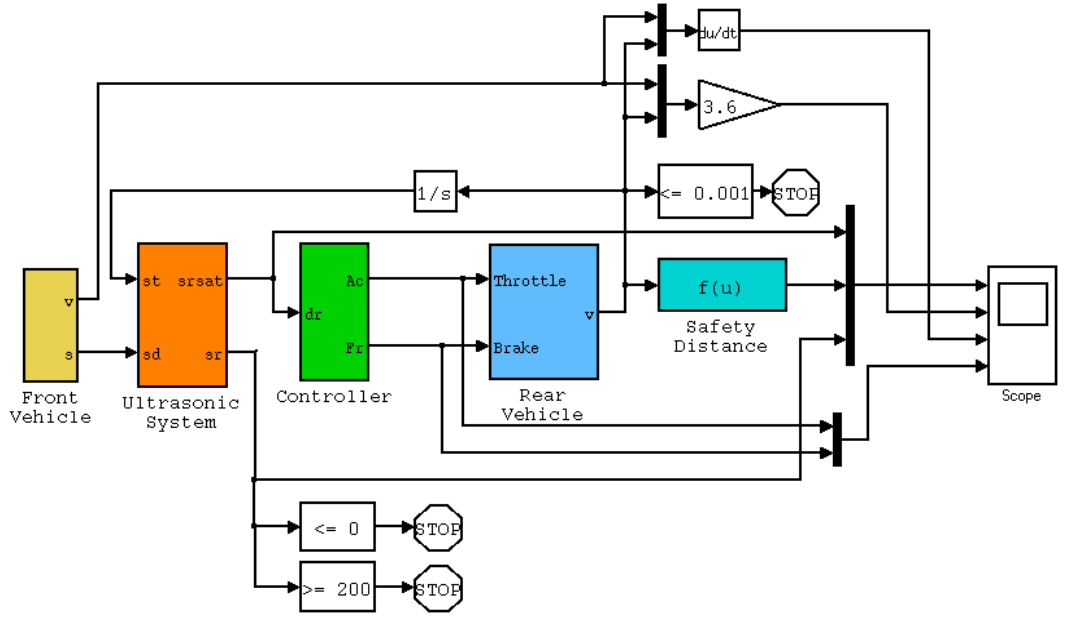
Figure 1. Matlab/Simulink block diagram used to perform